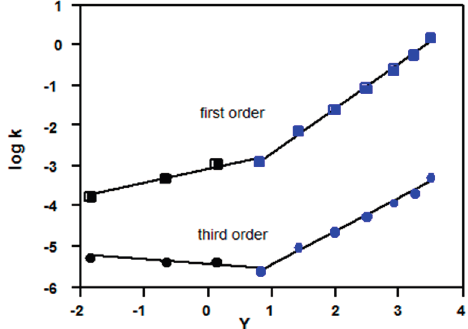
Figure 6. Comparison of plots of logarithms of first order rate constants (log k obs ) and third order rate constants (log k 3 , Equation (3)) vs. Grunwald-Winstein Y values [4,17] for solvolyses of benzoyl chloride ( 1 , Z = H) in acetone-water mixtures at 25 °C; kinetic data from Reference